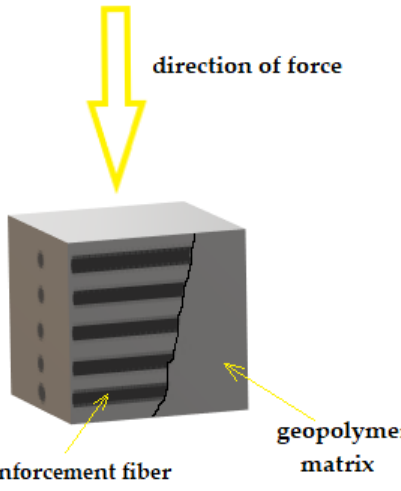
Figure 8. Method of testing for compressive strength. 2.2.2. Flexure Test Flexural strength tests were carried out according to EN 12390-5 ( “ Testing of hard- ened concrete. Flexural strength of specimens ” ) using a Matest 3000 kN universal testing machine (Matest, Treviolo, Italy). The dimensions of the specimens were 50 mm × 50 mm × 200 mm. The spacing between the support bars was 150 mm. The test speed was set at 0.5 MPa/s. Figure 9 shows the direction of force application in relation to the orientation of the long fibers in the geopolymer.